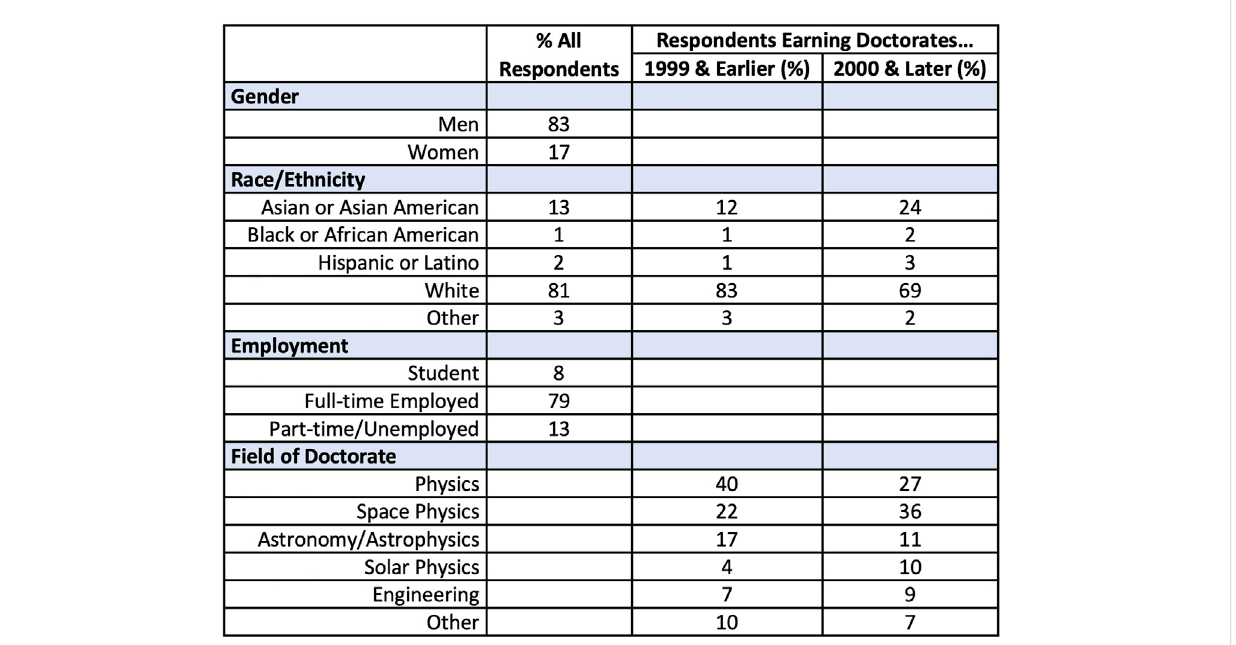
FIGURE 1 Results from the 2011 Survey of Solar, Space and Upper Atmospheric Physicists (White et al., 2011a). Responses were received from 1,171 individuals who resided in the US at the time of their response.